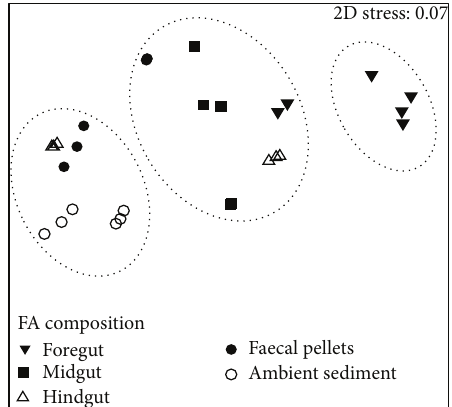
Figure 1: Nonmetric multidimensional scaling plot of the fatty acid composition ( 𝜇 gg −1 ) of ambient sediment, foregut, midgut, hindgut, and faecal pellets of Holothuria atra and Holothuria leucospilota